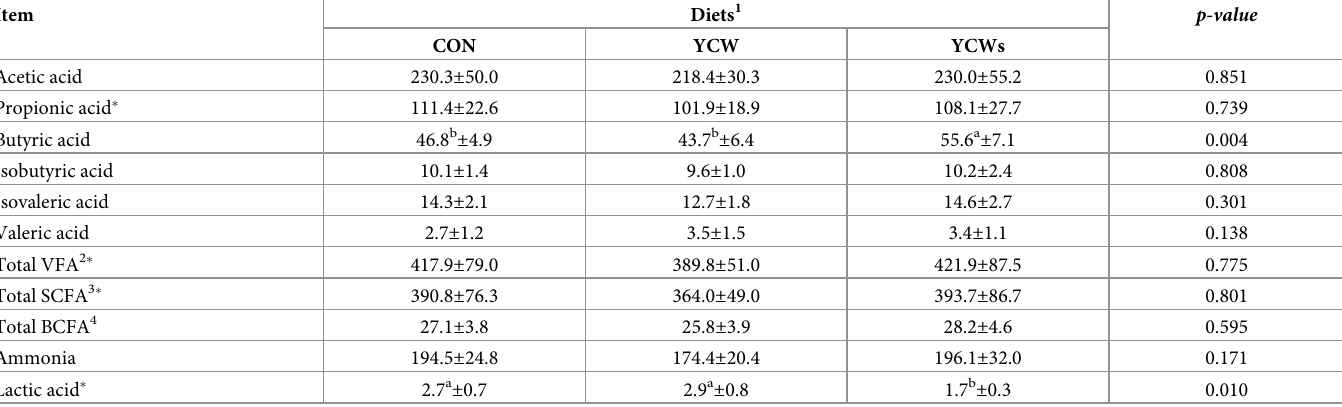
Table 5. Volatile fatty acids (mMol/g of dry matter), ammonia and lactic acid concentration (mMol/kg of dry matter) on the feces of dogs fed diets with the addition of different yeast cell wall preparations (mean and standard error of the mean). Item